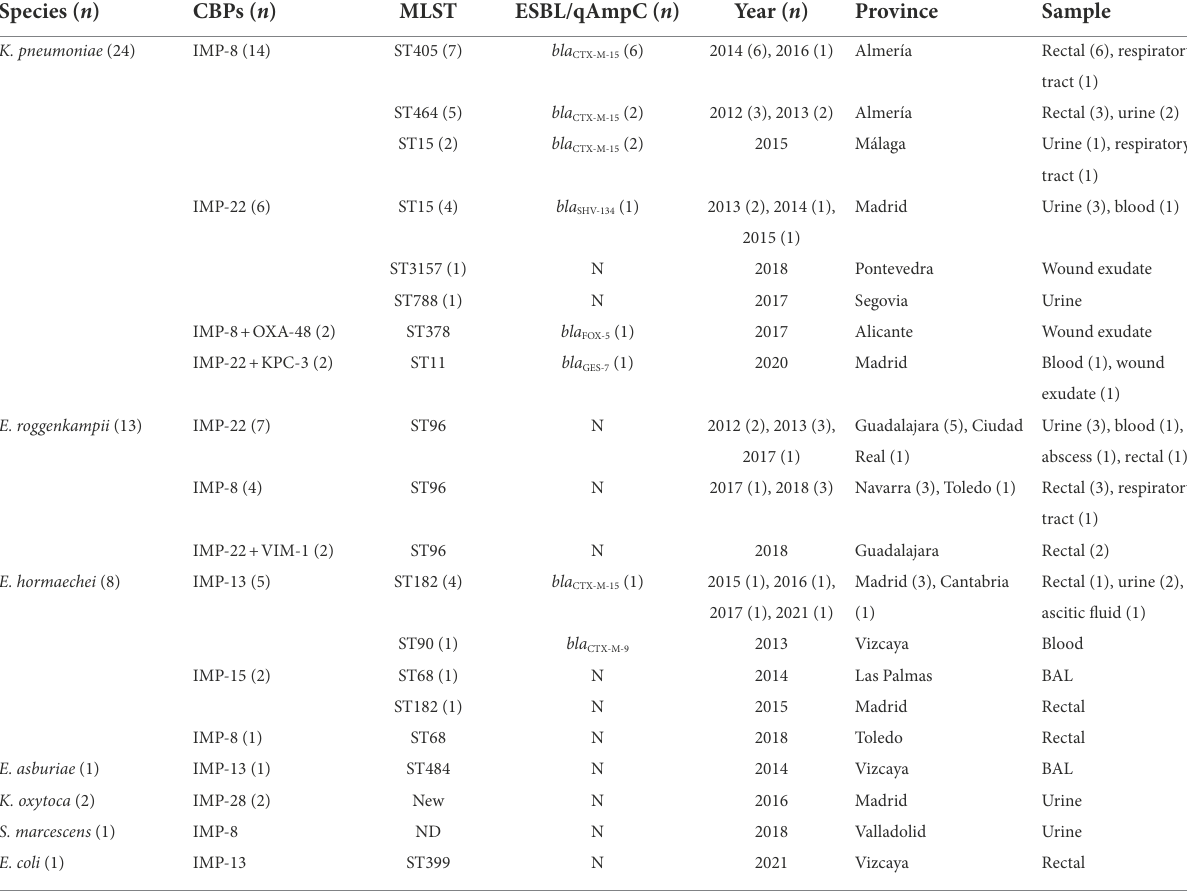
TABLE 1 Main microbiological and epidemiological features of the 50 IMP-producing Enterobacterales isolates included in this study. Species ( n